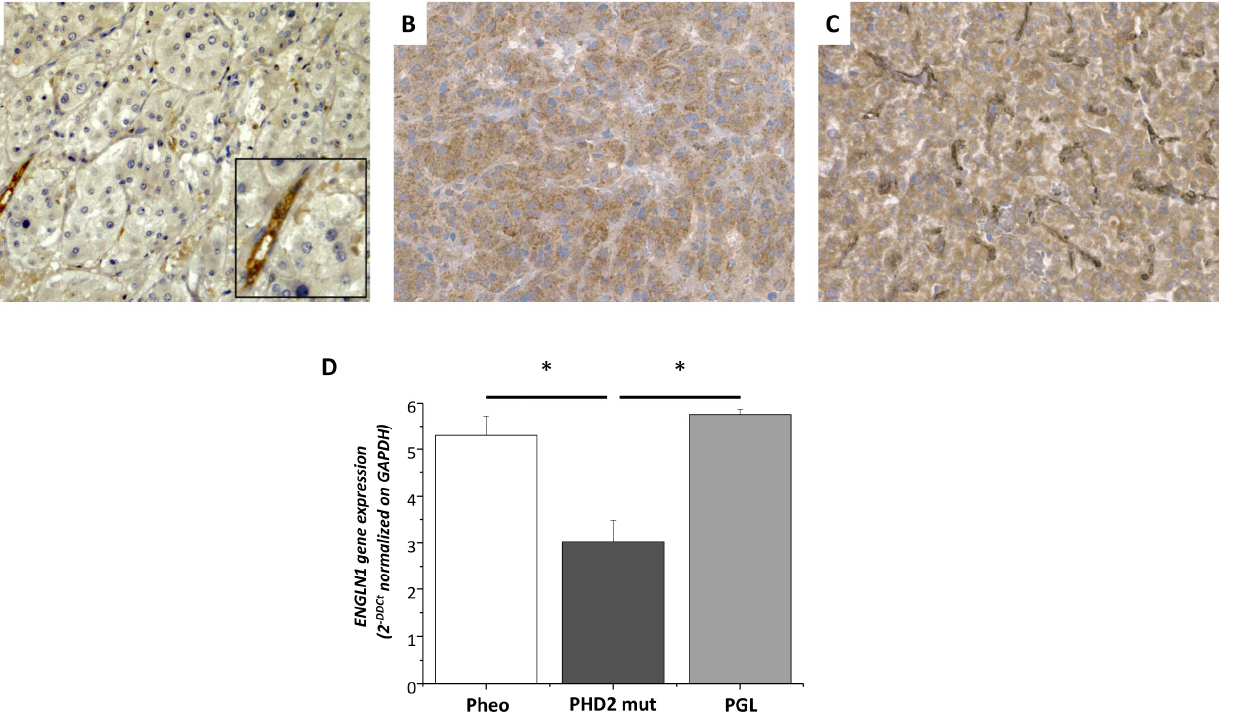
Figure 6. Immunohistochemical and QRT-PCR analyses for PHD2 expression. Patient neoplastic cells were not immunoreactive for anti-PHD2 antibody. Inset: strong PHD2 positivity was evident in the endothelial cells lining intra-tumoral capillaries (( A ), original magnification × 20). Tumor cells showing granular, cytoplasmic staining for PDH2 in pheochromocytoma wild type for Krebs cycle genes (( B ), original magnification × 20), and paraganglioma with SDHD gene pathogenic variant (( C ), original magnification × 20). Five pheochromocytoma samples characterized by different mutational profiles (2 wt, 1 mutated NF1 , 1 mutated RET , 1 mutated PHD2 ) and two PGL samples (1 wt and 1 SDHB -mutated) were subjected to quantitative RT-PCR. Data were expressed as mean ± SE of the EGLN1 gene expression level normalized to the GAPDH expression in 3 independent experiments. * p < 0.01 vs. PHD2 -mutated tissue ( D